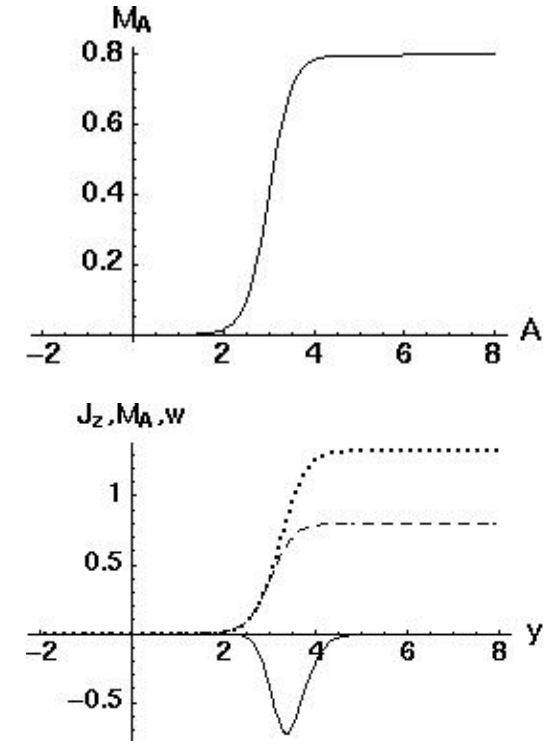
Fig. 1. Transformation from a one-dimensional homogenous current-free potential field A = B 0 y . Top panel: M A (A) as defined in (29), with M 1 = 0 . 4, M 2 = 0 . 8, d = 2, A c = 3 Bottom panel: M A (y) in dashed line, w(y) in thick dotted line and the resulting electric current density j z (y) in solid